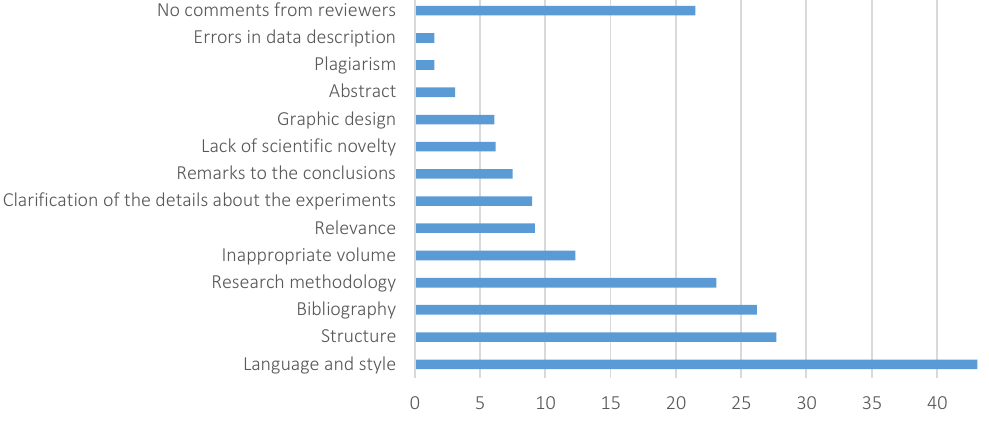
Figure 8. Reviewers’ comments in the case of a positive